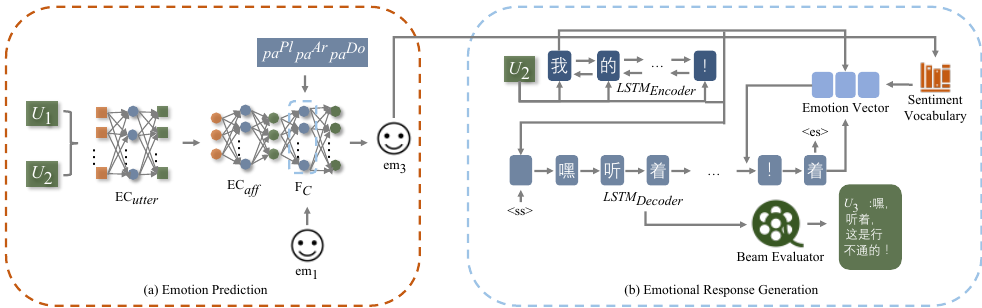
Figure 1. Structure of GERP. The Emotion Prediction module ( a ) predicts an emotion em 3 based on the history dialogue U 1 and U 2 , the initial emotion em 1 , and the chatbot’s personality pa . In the Emotional Response Generation module ( b ), the emotional response U 3 is generated using LSTM decoder under the supervision of the emotion vector obtained from em 3 . GERP is a Chinese personalized emotional dialogue system which settles U 2 and generates U 3 in